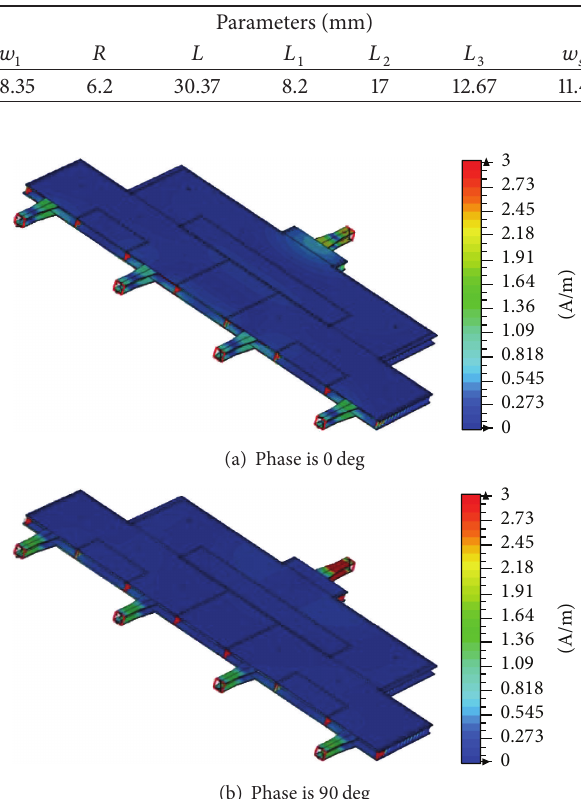
Figure 6: Surface current of the 4-way SIW power divider.